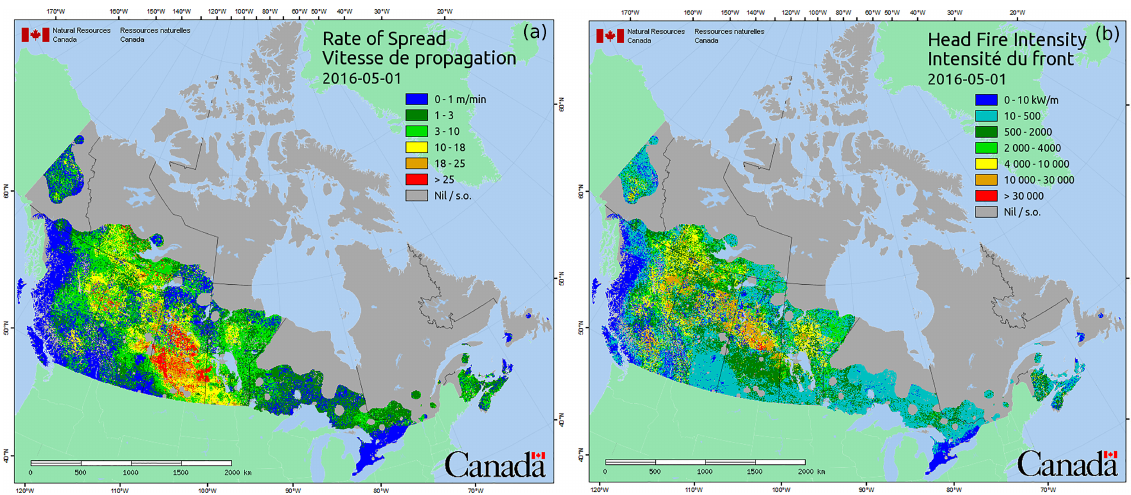
Figure 4. (a) Fire rate of spread and (b) head fire intensity in Canada on 1 May 2016 (Natural Resources